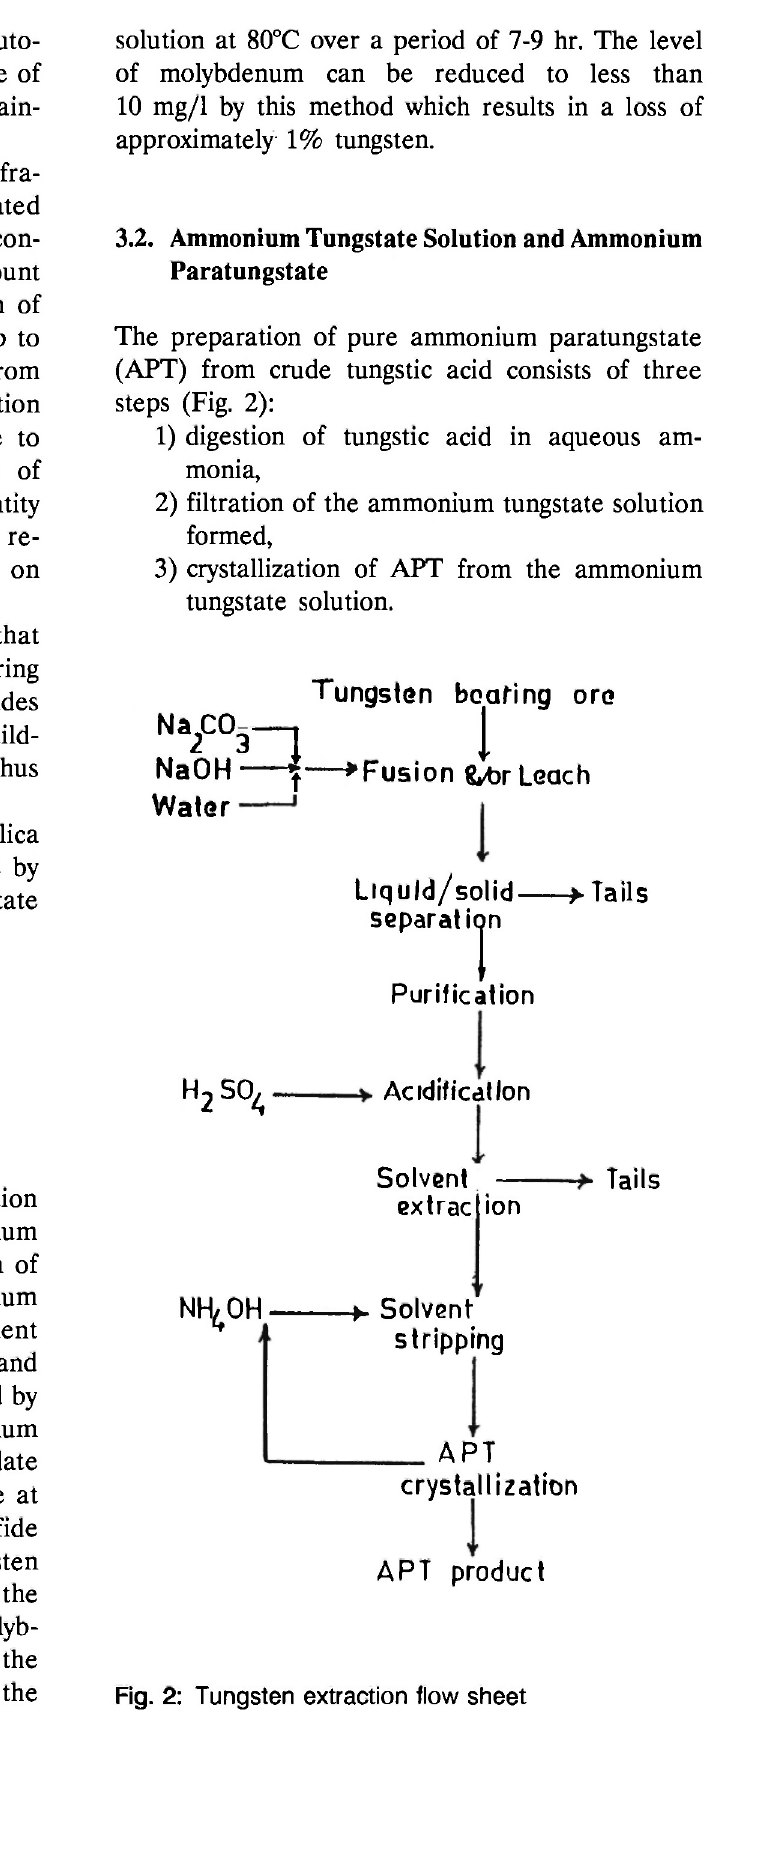
Fig. 2: Tungsten extraction flow